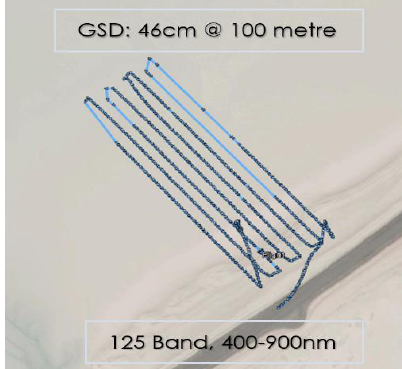
Figure 9. Study site Tuz Golu and route of our Unmanned Aerial System